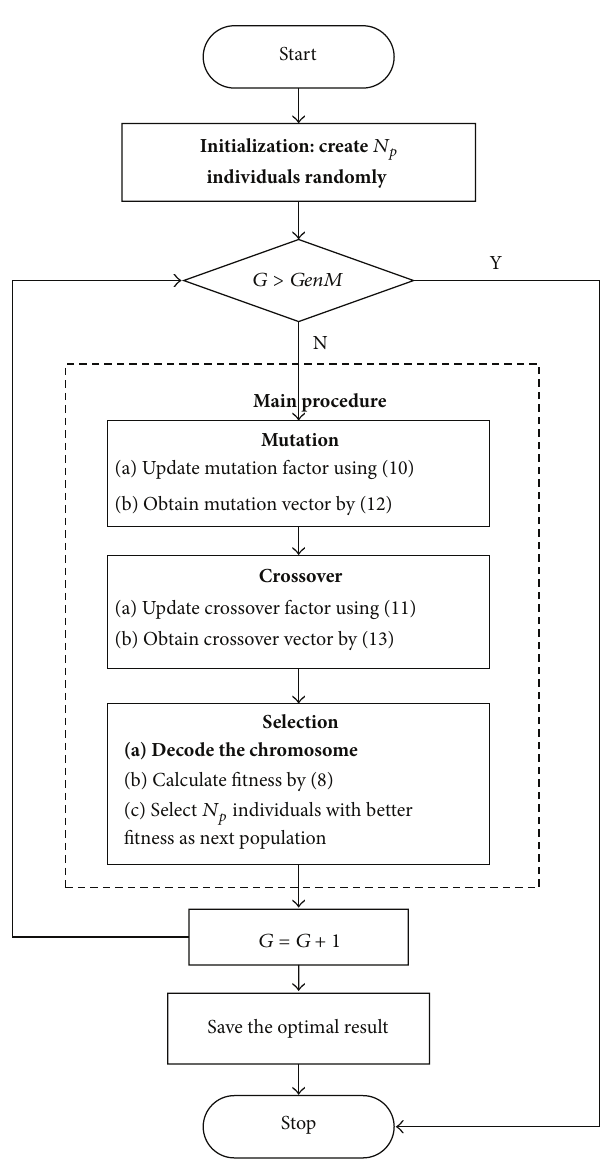
Figure 2: Flow chart of HSDE for the JR-LIP.